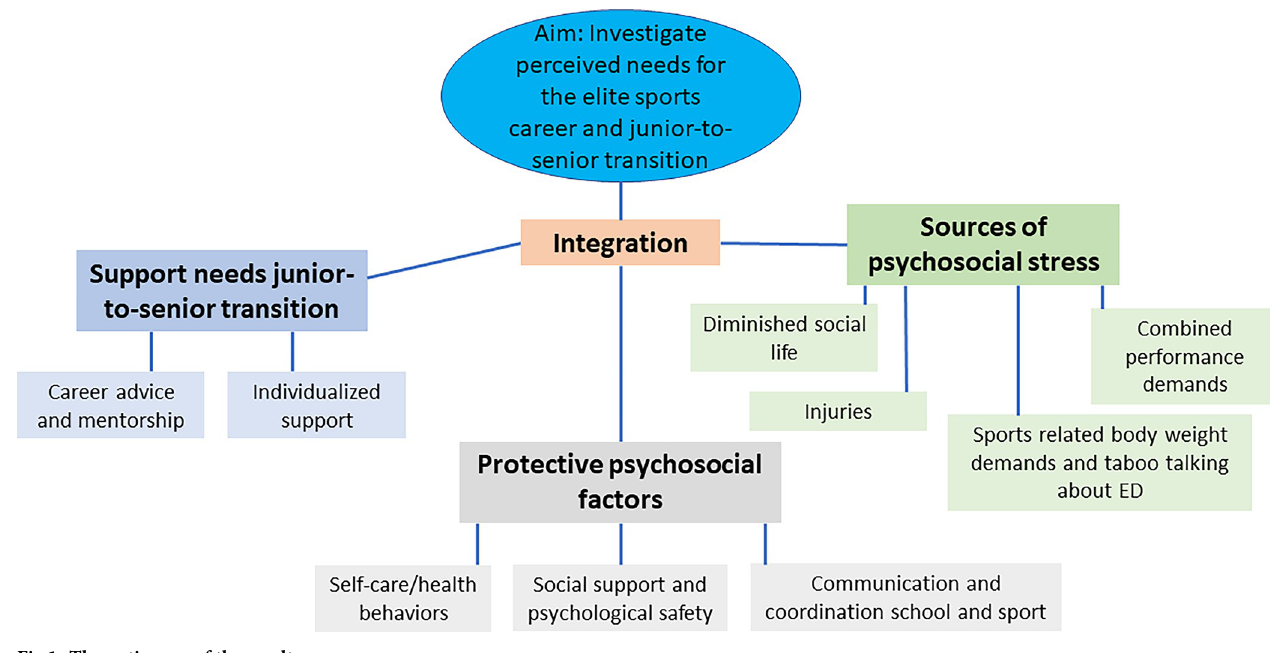
Fig 1. Thematic map of the